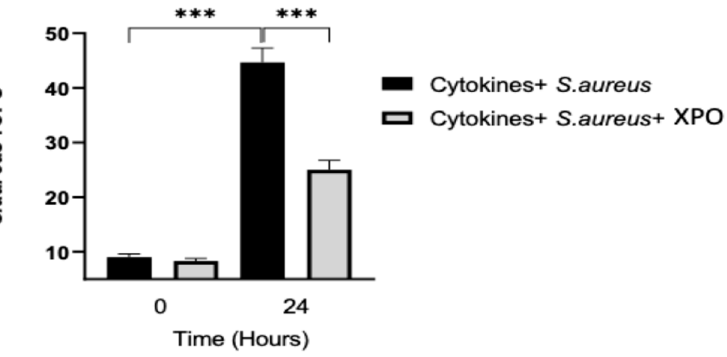
Figure 4. Relative number of CFUs (rCFUs). S. aureus adhesion rate was calculated and the relative number of CFUs (rCFUs) was estimated by plating out the lysate of infected cells and counting the number of CFUs at T0 and T24 h. XPO treatment was able to prevent S. aureus infection, reducing bacterial adherence. Values are indicated as the mean ± SEM. *** p < 0.001.